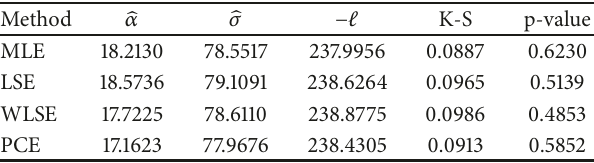
Table 10: The goodness of fit statistics for parameter estimated under various methods for